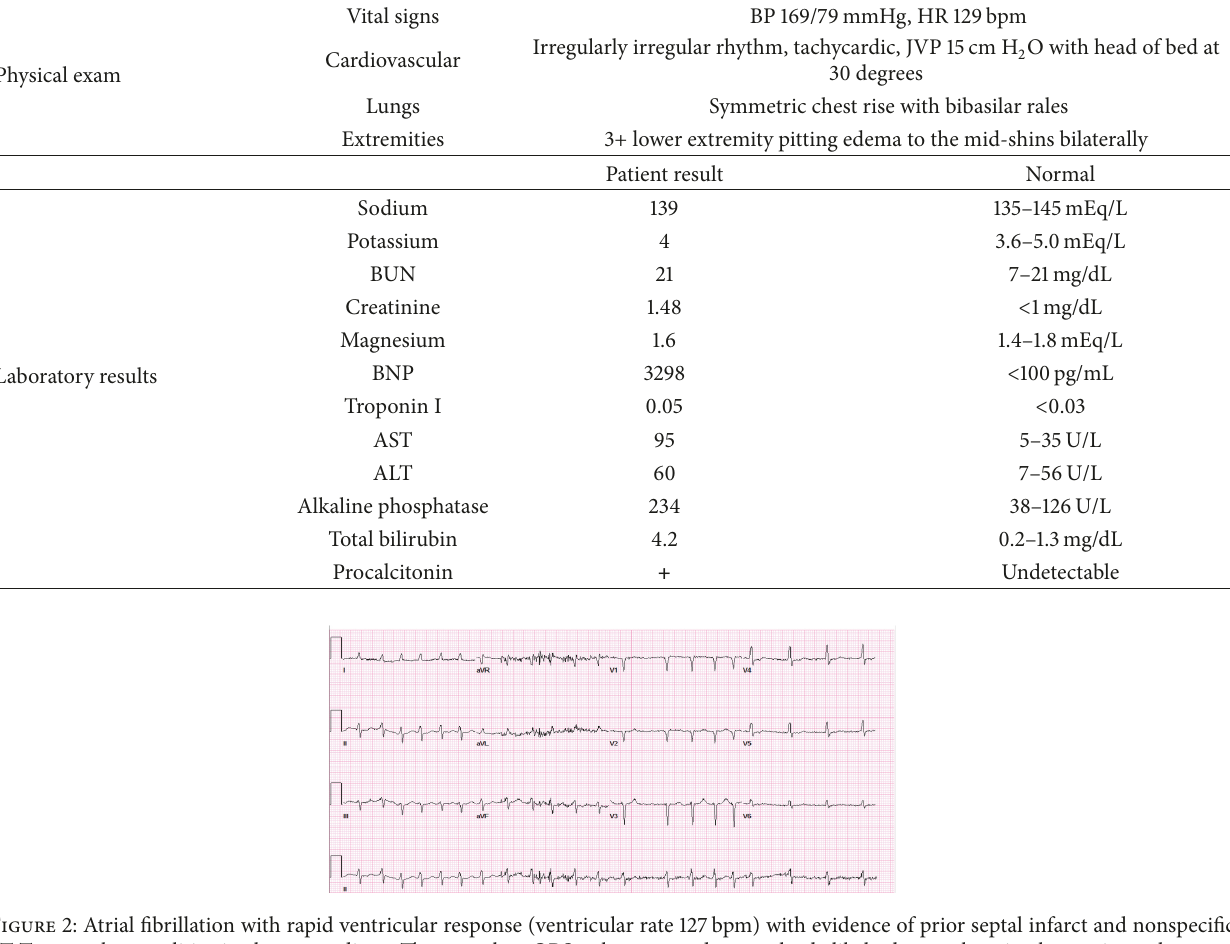
Figure 2: Atrial fibrillation with rapid ventricular response (ventricular rate 127bpm) with evidence of prior septal infarct and nonspecific ST-T wave abnormalities in the precordium. There are low QRS voltages noted across leads likely due to chronic obstructive pulmonary